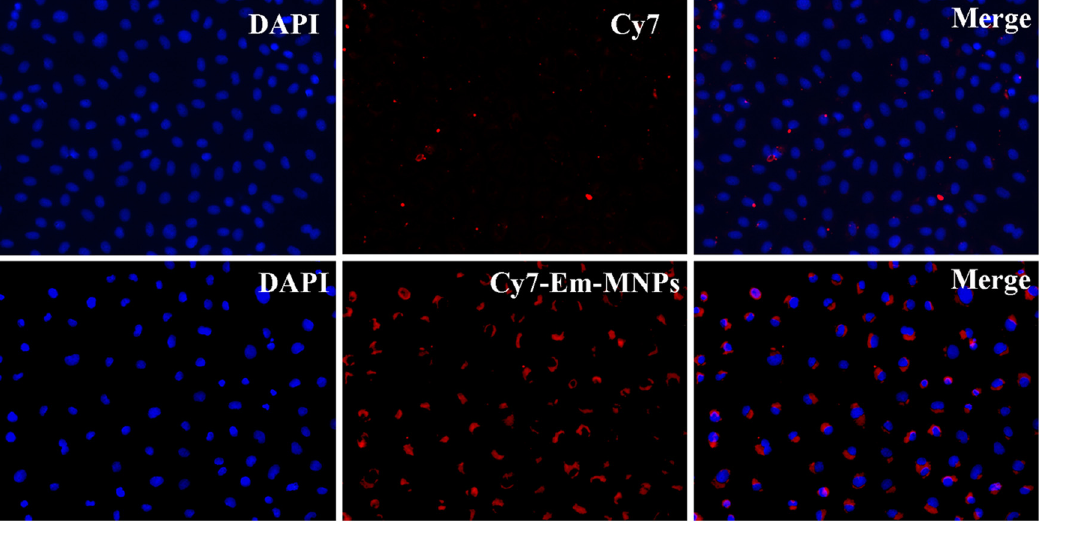
Figure 7: Cellular uptake images. NRK - 52E cells incubated with Cy7 and Cy7 - Em - MNPs for 2 h. Images were captured in 400 × magni fi